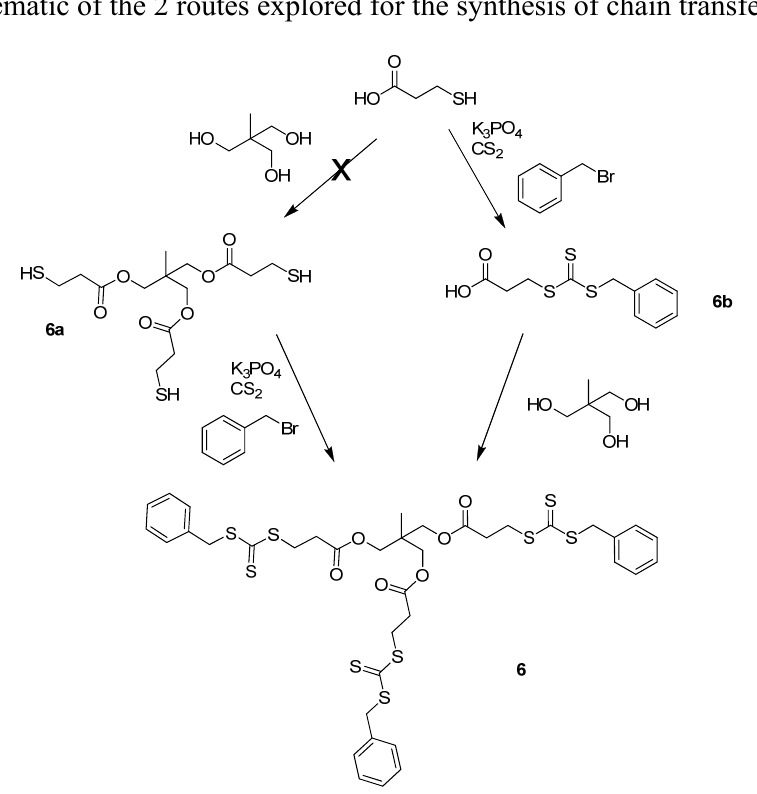
Scheme 5. Schematic of the 2 routes explored for the synthesis of chain transfer agent 6